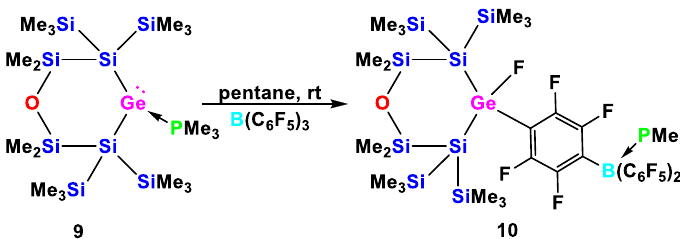
Figure 5. Molecular structure of compound 9 (thermal ellipsoid plot drawn at the 30% probability level). All hydrogen atoms are omitted for clarity (bond lengths in Å, angles in deg). Ge(1)-P(1) 2.3570(13),